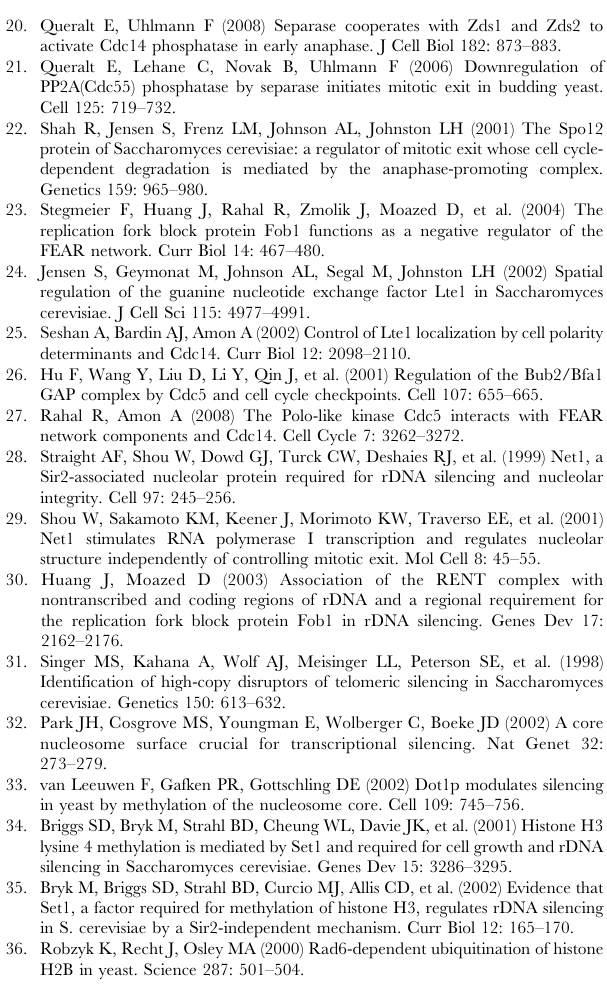
Figure S3 Cell cycle progression of cdc15-2 mad1 D and cdc15-2 mad1 D bre1 D mutants. The DNA content profile of cdc15-2 mad1